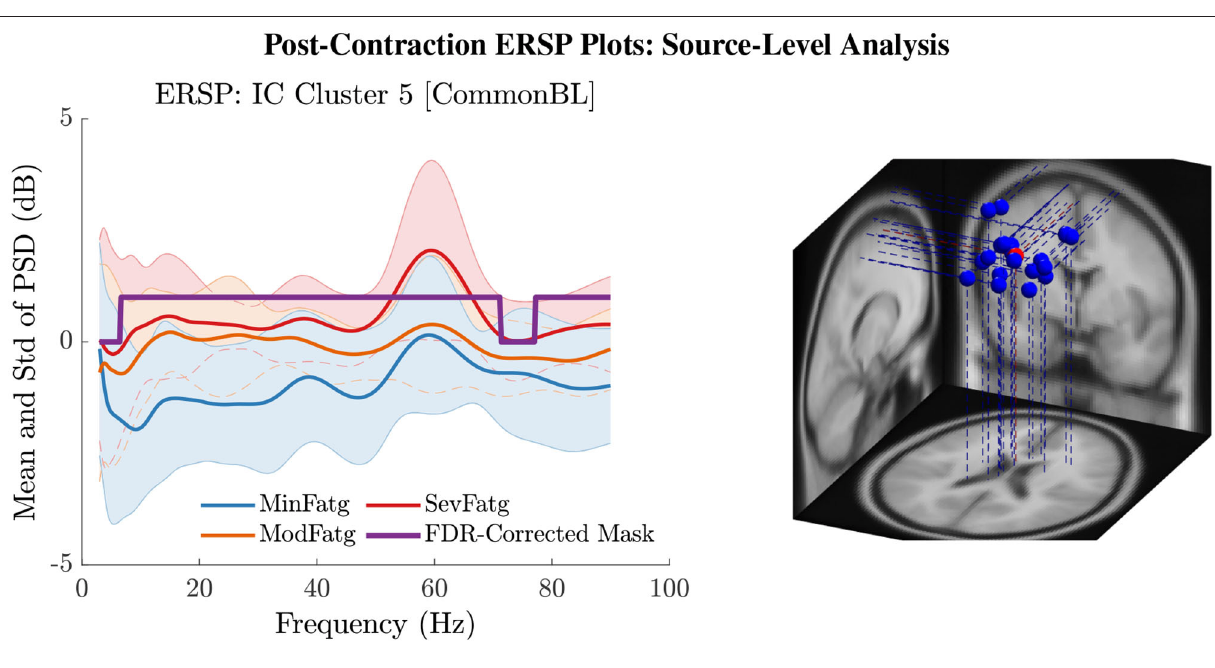
The subject-wise baseline PSD averaged over the trials in dB was averaged over the task-related (steady or post- contraction) baseline time interval and a specific frequency band, in a given fatigue condition B FatgCond was log-transformed j FatgCond B AVG ]. The quantity thus expressed as 10 log [B FatgCond denoted as ≈ B collectively for N subjects 10 j −